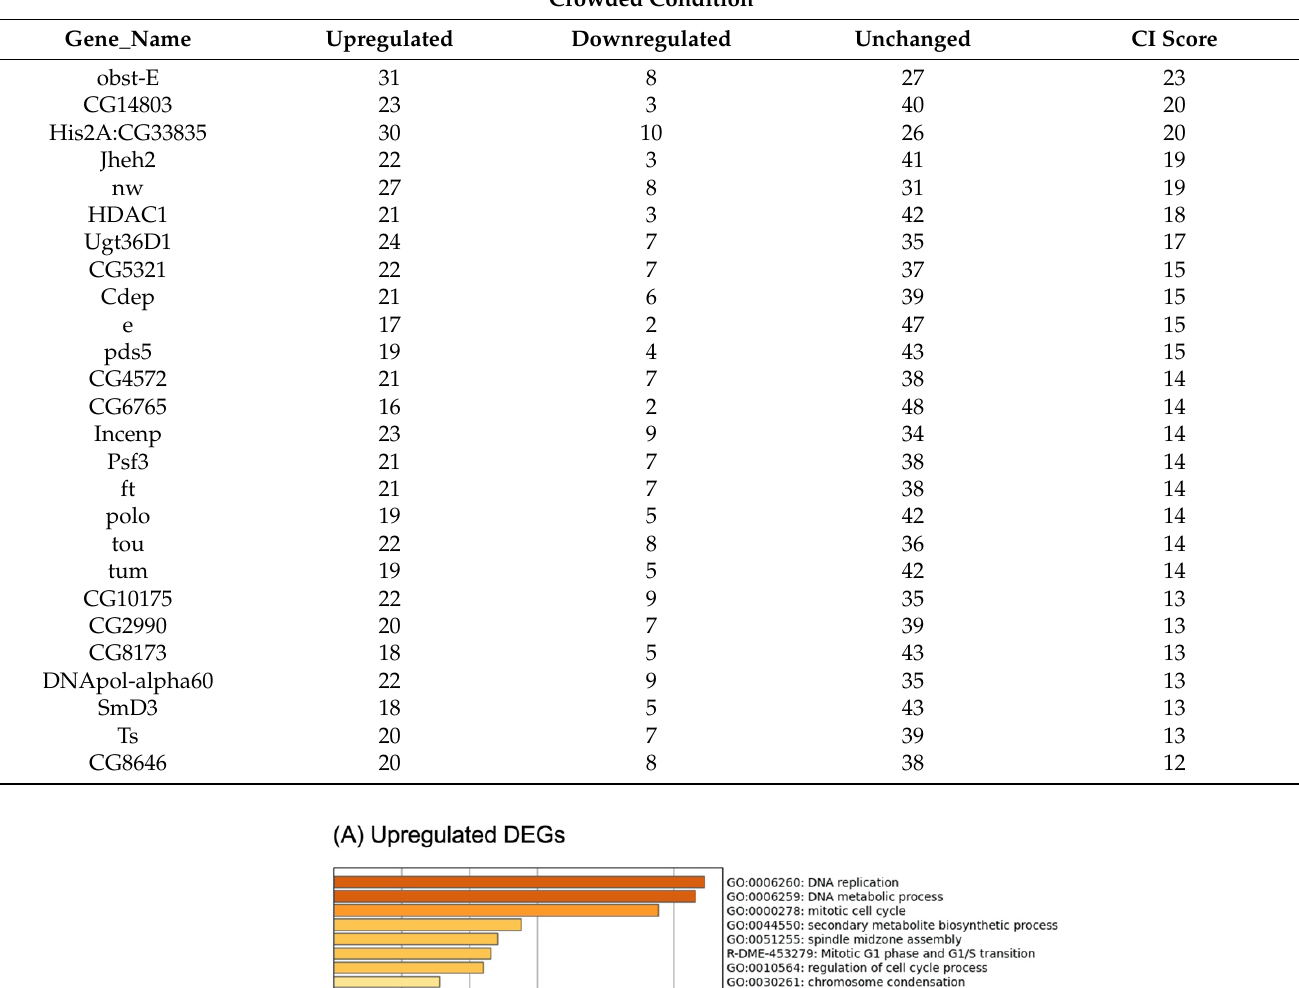
Table 2. Top 1% of genes with the highest CI scores. Number of Samples with Expression Patterns Responding to the